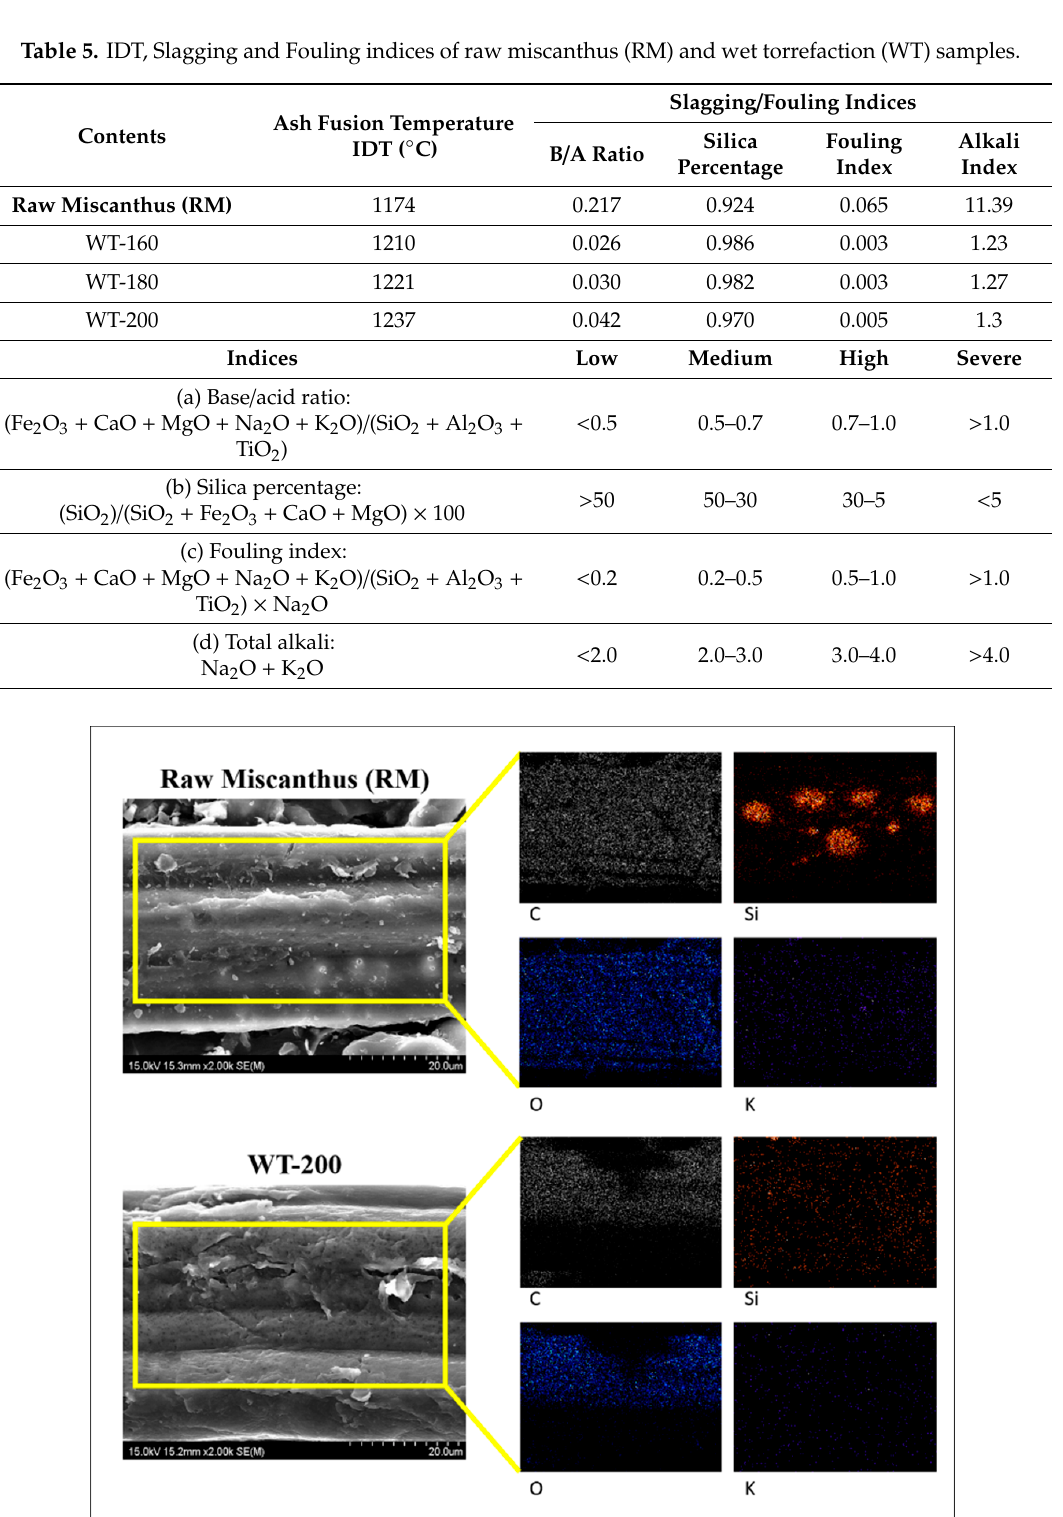
Figure 3. SEM and X-ray maps for major ash elements on the surface of Raw Miscanthus (RM) and WT-200.